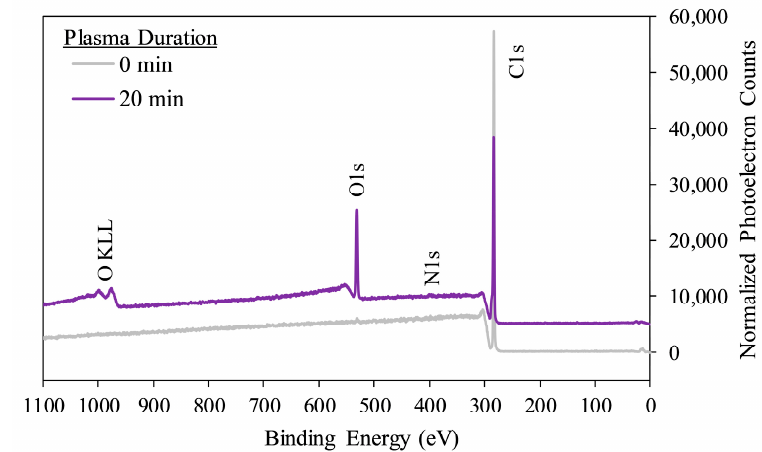
Figure 2. Representative XPS survey scans (rescaled to normalize areas under curves) of the 0 and 20 min time points demonstrate increasing height of the O1 s peak with plasma treatment. KLL peaks indicate atomic relaxation via the Auger effect (with the acronym reflecting the K and L electron orbital shells involved in the energy transition), and were not used for analysis. Spectra are intentionally offset from each other along the vertical axis.